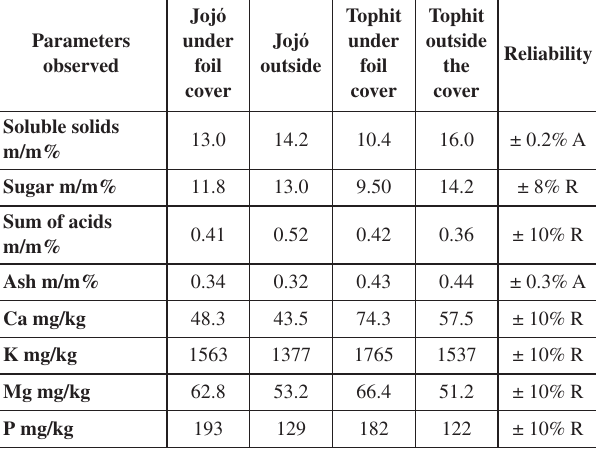
Table 1. Parameters of inner quality of plum fruits grown under plastic foil or outside the cover (Debrecen-Pallag, 2010)